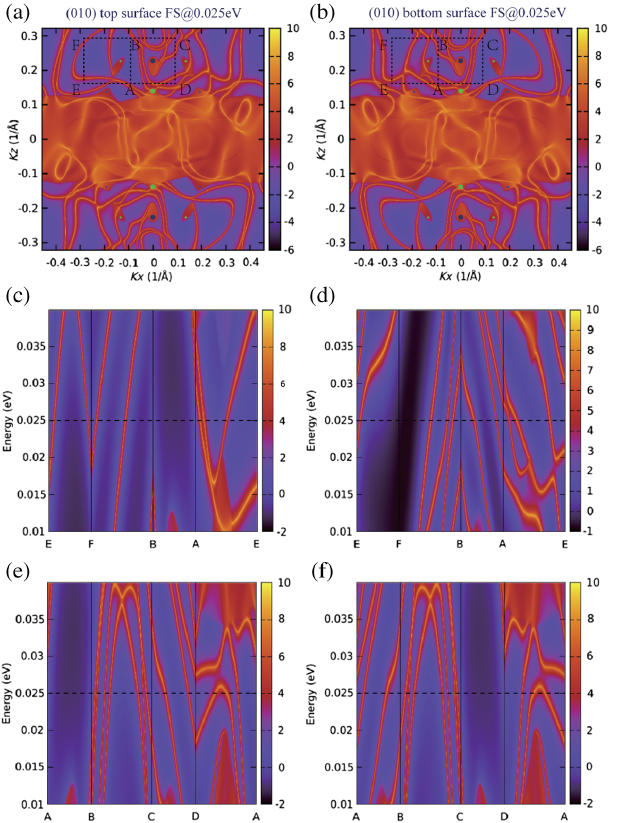
FIG. 12. Surface state of the second cleaved cell with a surface potential energy of − 0 . 4 eV. (a,b) Fermi surface on the top and bottom (010) surfaces, respectively. The small dots represent the single projected WP, and the large dots represent two WPs with the same chirality projecting on top of each other. Panels (c) and (e) are the surface states of the top surface along the closed paths of E-F-B-A-E and A-B-C-D-A, respectively. Panels (d) and (f) are the same as (c) and (e) but for the bottom